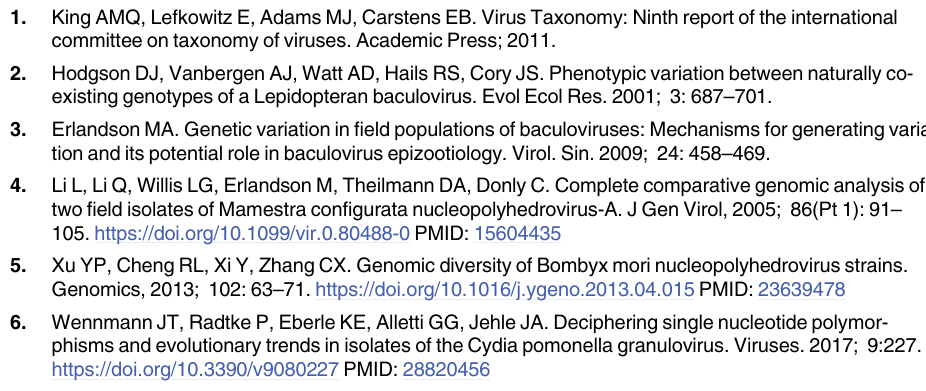
S1 Table. Mutation frequency of eight PlxyGV isolates relative to the PlxyGV-W genome sequence in coding, noncoding and hr regions ( × 10 − 3 ). S2 Table. The transcription start sites and polyadenylation sites of PlxyGV specific